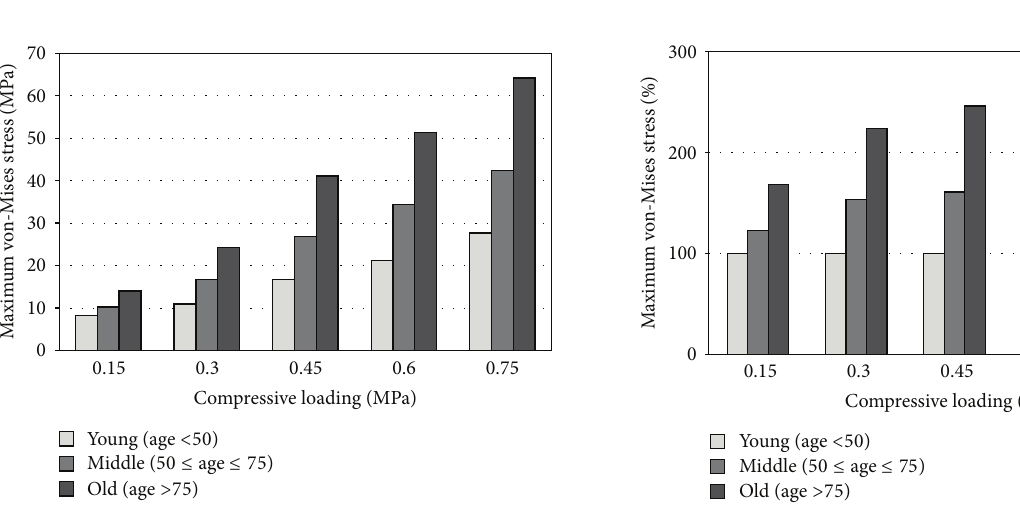
Figure 3: Cross-sectional view in the middle sagittal plane of the von-Mises stress distribution for the three age groups under 0.15 MPa, 0.3 MPa, 0.45 MPa, 0.6 MPa, and 0.75 MPa of compressive loading.